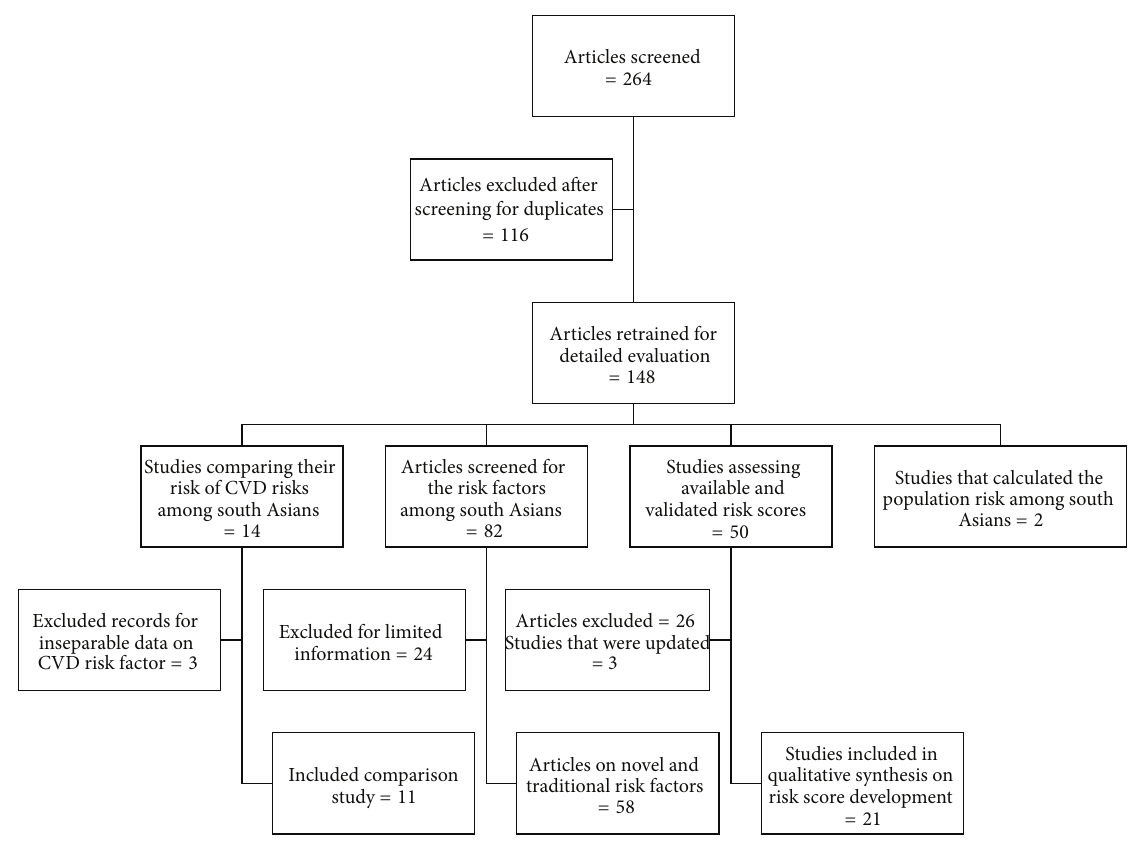
Figure 1: Flow diagram for the included